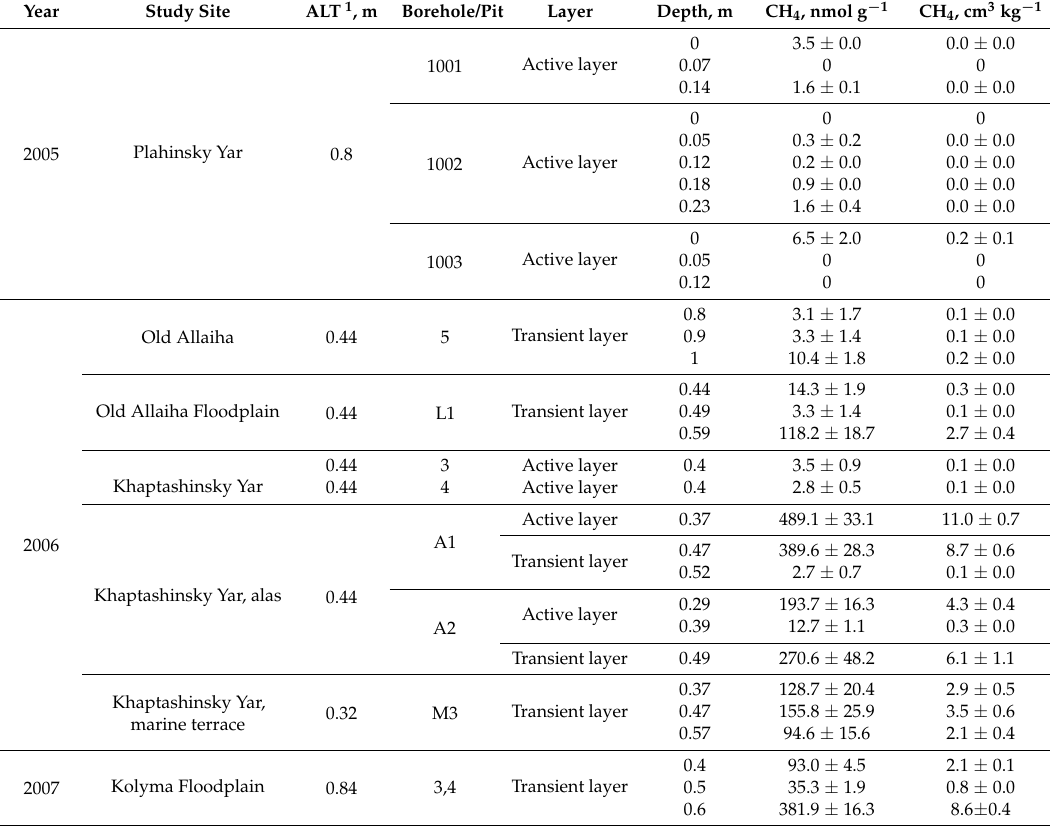
Table A2. Methane concentration in the active layer and periodically thawed layer of permafrost.